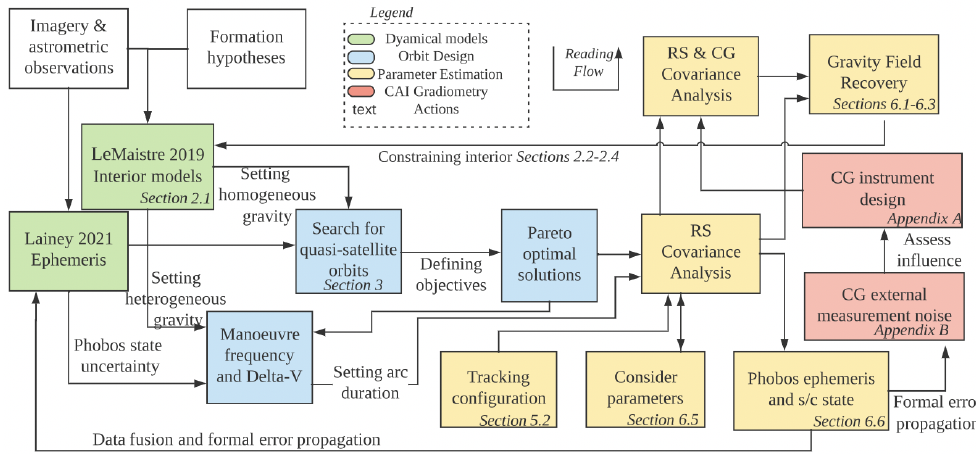
Figure 4. Flowchart summarising the methodology adopted in this work and the relevant